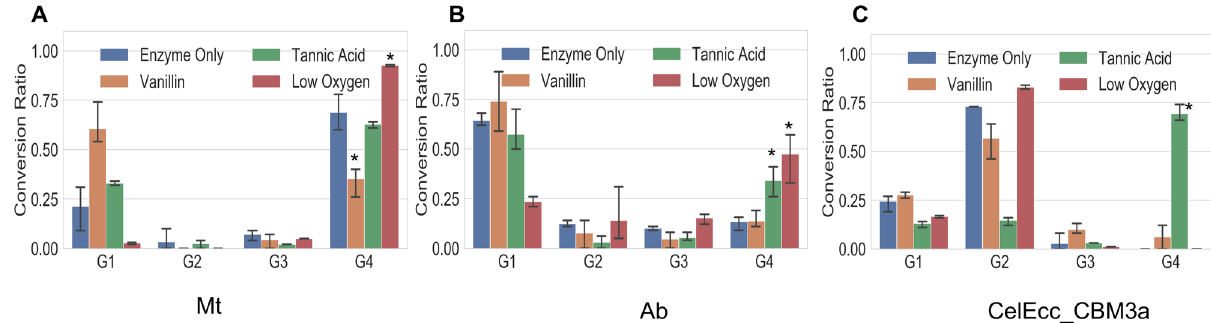
Figure 4. Effect of mediators and inhibitory conditions on cellotetraose degradation by ( A ) Mt ( B ) Ab and ( C ) CelE CBM3a (n = 3) . “*” indicate ANOVA post hoc significant differences compared to enzyme only. Enzyme loading concentrations were 1.4 μg and 0.3 μg per 1 mM cellotetraose for Mt and Ab, respectively. (G1 = glucose; G2 = cellobiose; G3 = cellotriose; G4 = cellotetraose) Inhibition reaction was run at 37 °C for 20 min; Oxime tagging reaction time = 22